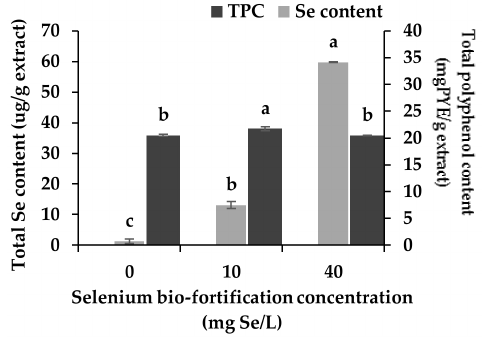
Figure 1. Total selenium (Se) content ( µ g/g extract) (left axis) and total polyphenol content (right axis) of ricegrass juice extract after being bio-fortified with various concentrations of sodium selenite (0, 10 and 40 mg Se/L) during plantation. Each treatment was tested in triplicate. Data are means ± standard deviation (SD). Different letters indicated significant differences ( p < 0.05) in Duncan’s significant differences test. PYE: pyrogallol